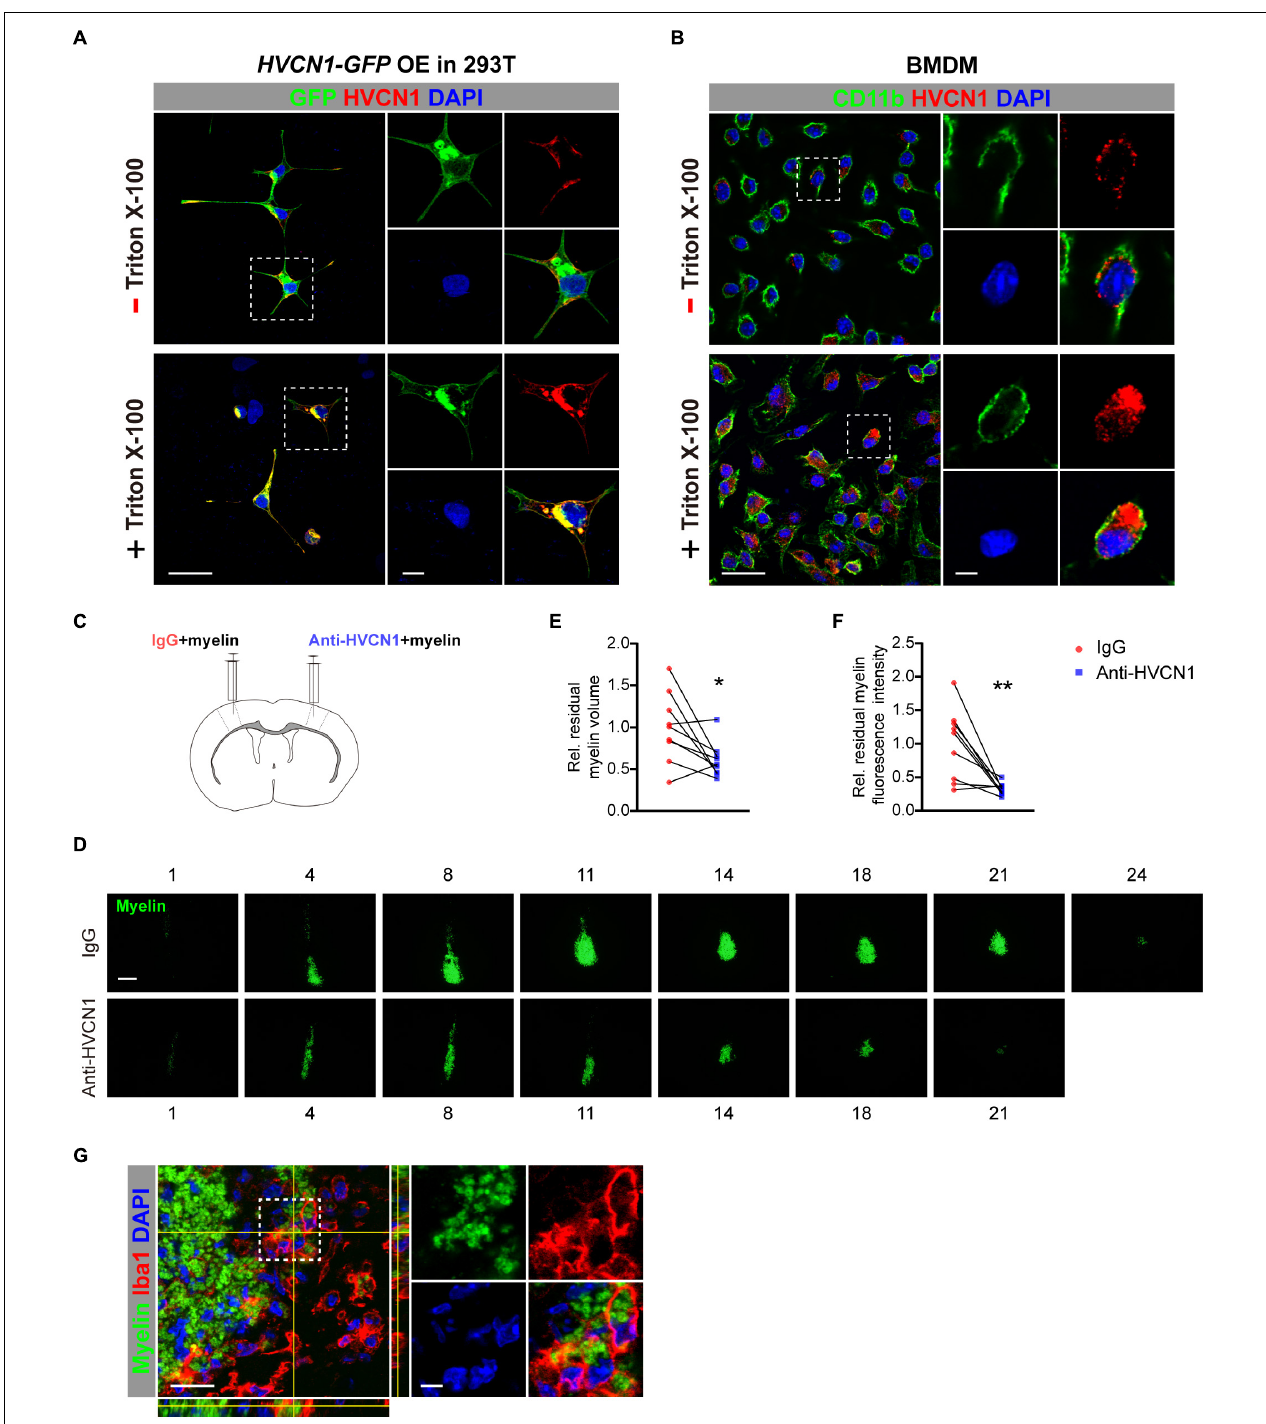
FIGURE 10 | Neutralizing HVCN1 with antibody enhances myelin debris clearance in the brain. (A,B) The binding patterns of the HVCN1 antibody to cells without (upper row) or with Triton X-100 permeabilization (lower row). Confocal images of GFP (green), HVCN1 (red) in 293T cells overexpressed with Plenti-HVCN1-GFP (A) . Confocal images of CD11b (green), HVCN1 (red) in BMDM cells (B) . (C) Schematic in vivo experiment design: CFSE labeled myelin was co-injected with IgG on one side or with an HVCN1 antibody on the other side of the S1 cerebral cortex of the mouse. (D–F) Representative images of the residual myelin (green) taken in every 36 or 48 µ m thickness of brain section (D) and quantification of its volume (E) and its fluorescence intensity (F) ( n = 9). (G) Confocal images of the Iba1 + microglia (red), HVCN1 (gray), and phagocytized myelin (green). Scale bars = 100 µ m (D) or 20 µ m (A,B,G) , and the side length of the dashed-line square = 5 µ m (A,B,G) . Data are presented as mean ± SEM. Statistical tests: paired two-tailed t -test (E,F) ; * p < 0.05, ** p < 0.01.